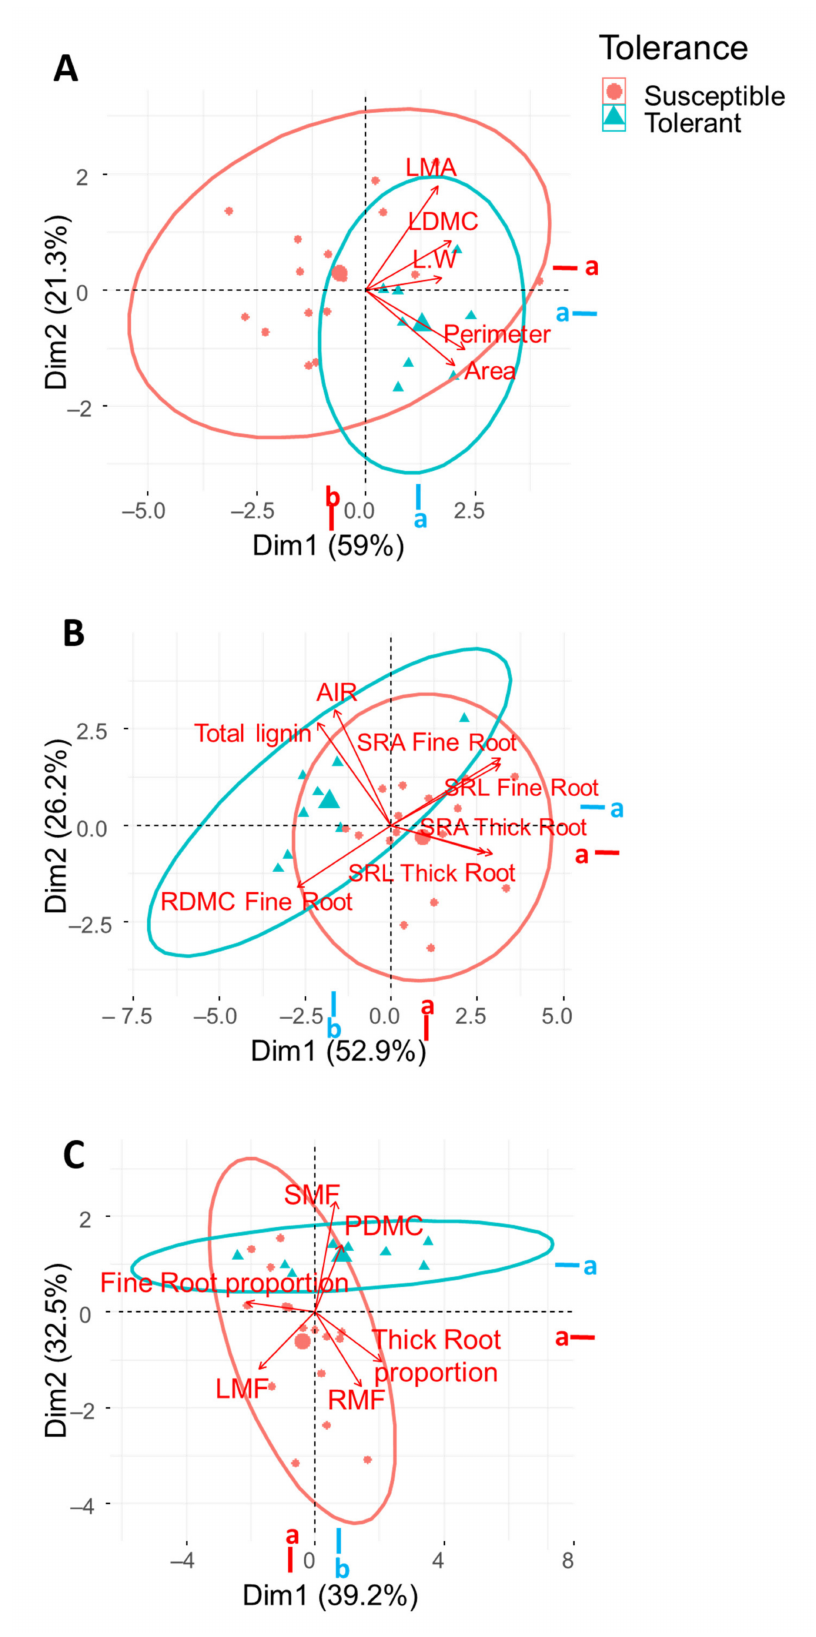
Figure 2. Principal Component Analysis (PCA) of leaf ( A ), root ( B ) and plant ( C ) traits performed with ‘tolerance’ as factor, and the contribution of variables on the main two axes of PCA.